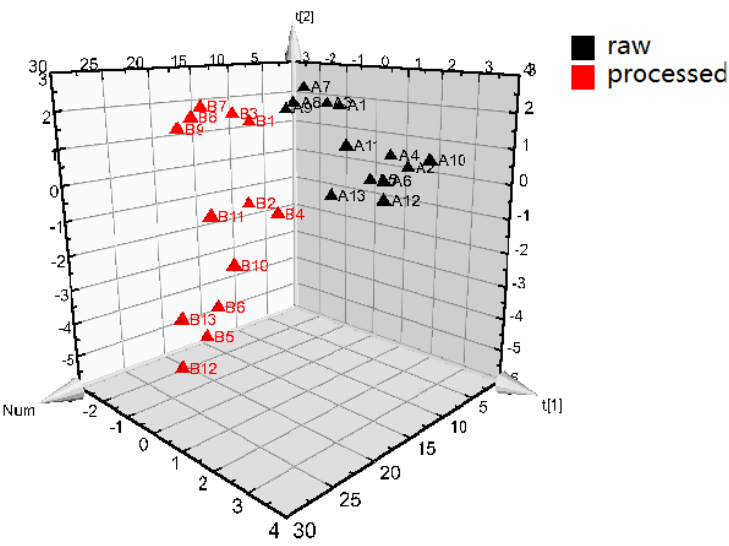
Figure 4. Partial least squares discriminant analysis (PLS-DA) 3D score scatter plot for raw (A) and processed (B) Epimedium (R2X = 0.656, R2Y = 0.418, Q2 = 0.081).